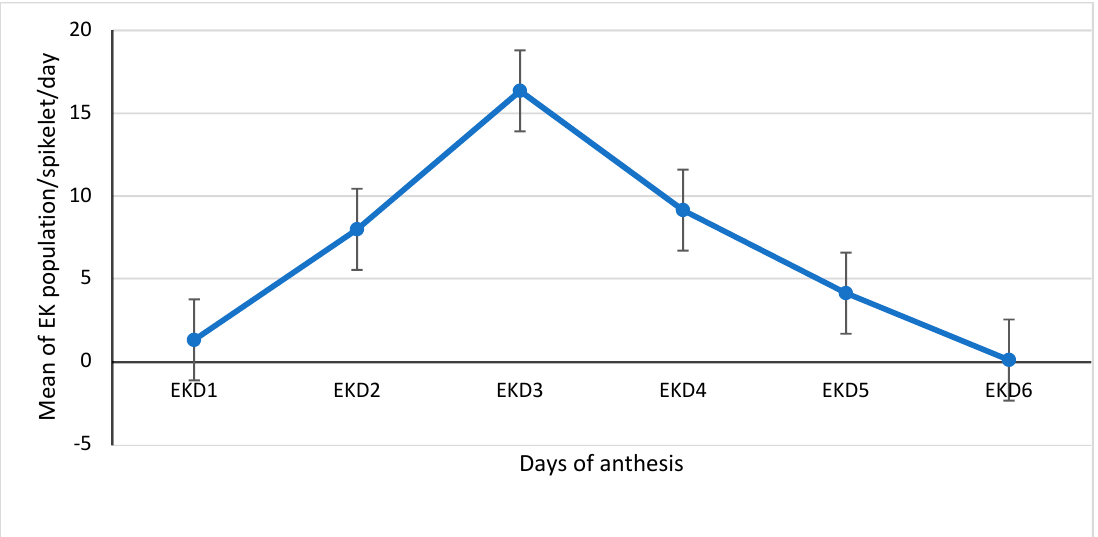
Figure 5. Mean of all hybrids of Elaeidobius kamerunicus (EK) population that emerged on male inflorescence per spikelet on each anthesis day (1–6). Means and the standard error are presented in the figure as each data point: EKD1 (EK day-one), EKD2 (EK day-two), EKD3 (EK day-three), EKD4 (EK day-four), EKD5 (EK day-five), and EKD6 (EK day-six).